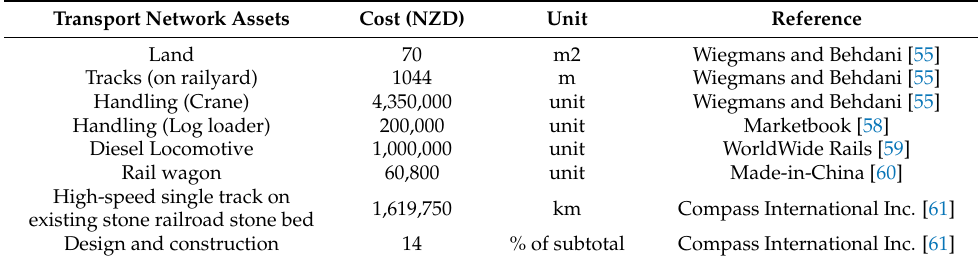
Table A1. Reference values for costing analysis.